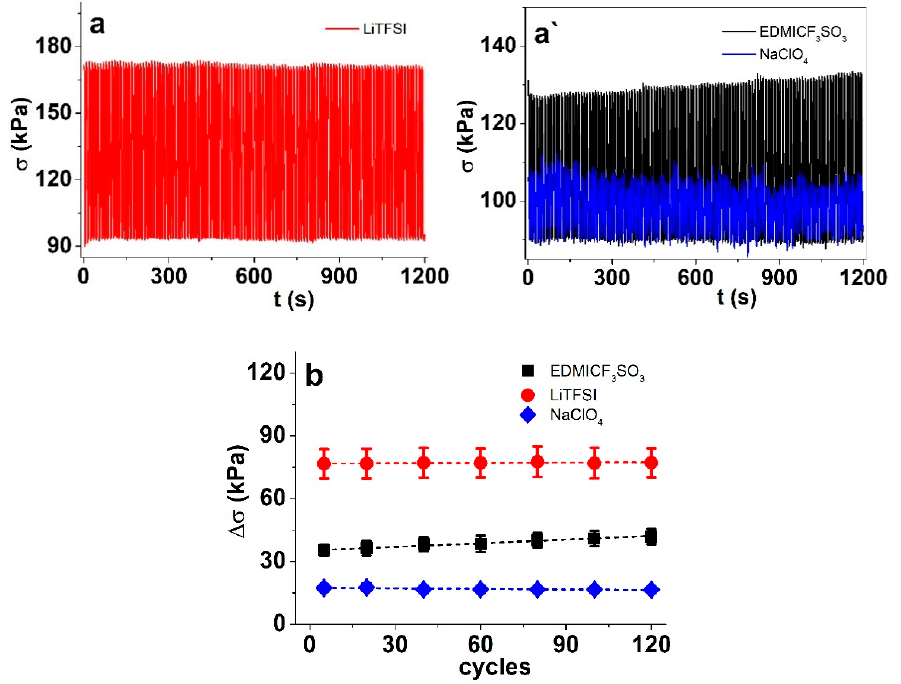
Figure 5. Stress response stability during square wave potential steps (0.1 Hz) for PP–IPN layers in EDMICF 3 SO 3 (black, ■ ), LiTFSI (red, ● ) and NaClO 4 (blue, ♦ ) in ( a , a`) : stress (blocking force) vs. time; ( b ) stress difference vs. cycle number.